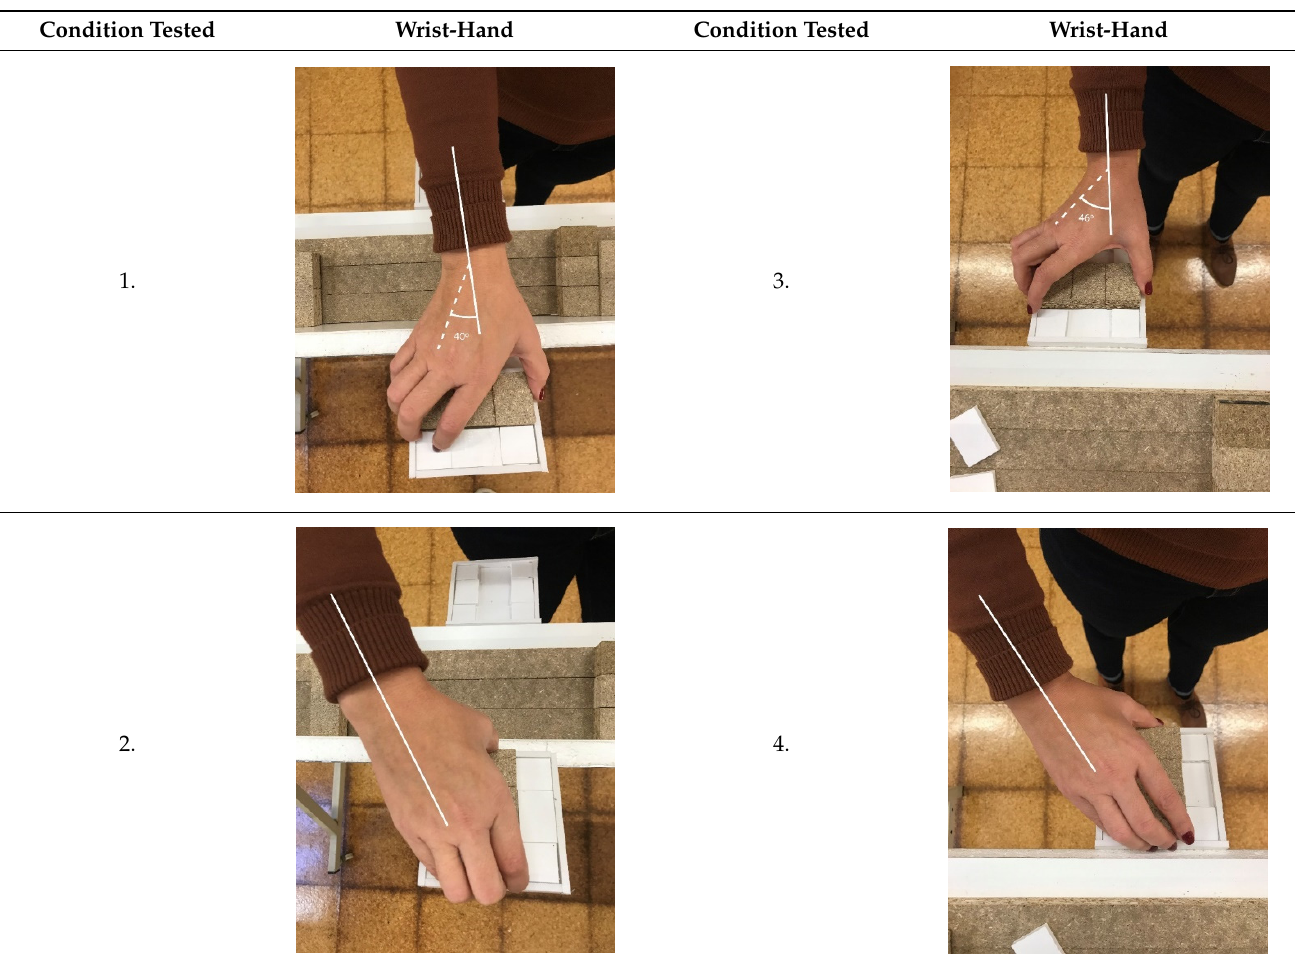
Figure 9 . The prototype of the hybrid assembly workstation. Table 3. Wrist-hand postures across the conditions tested.